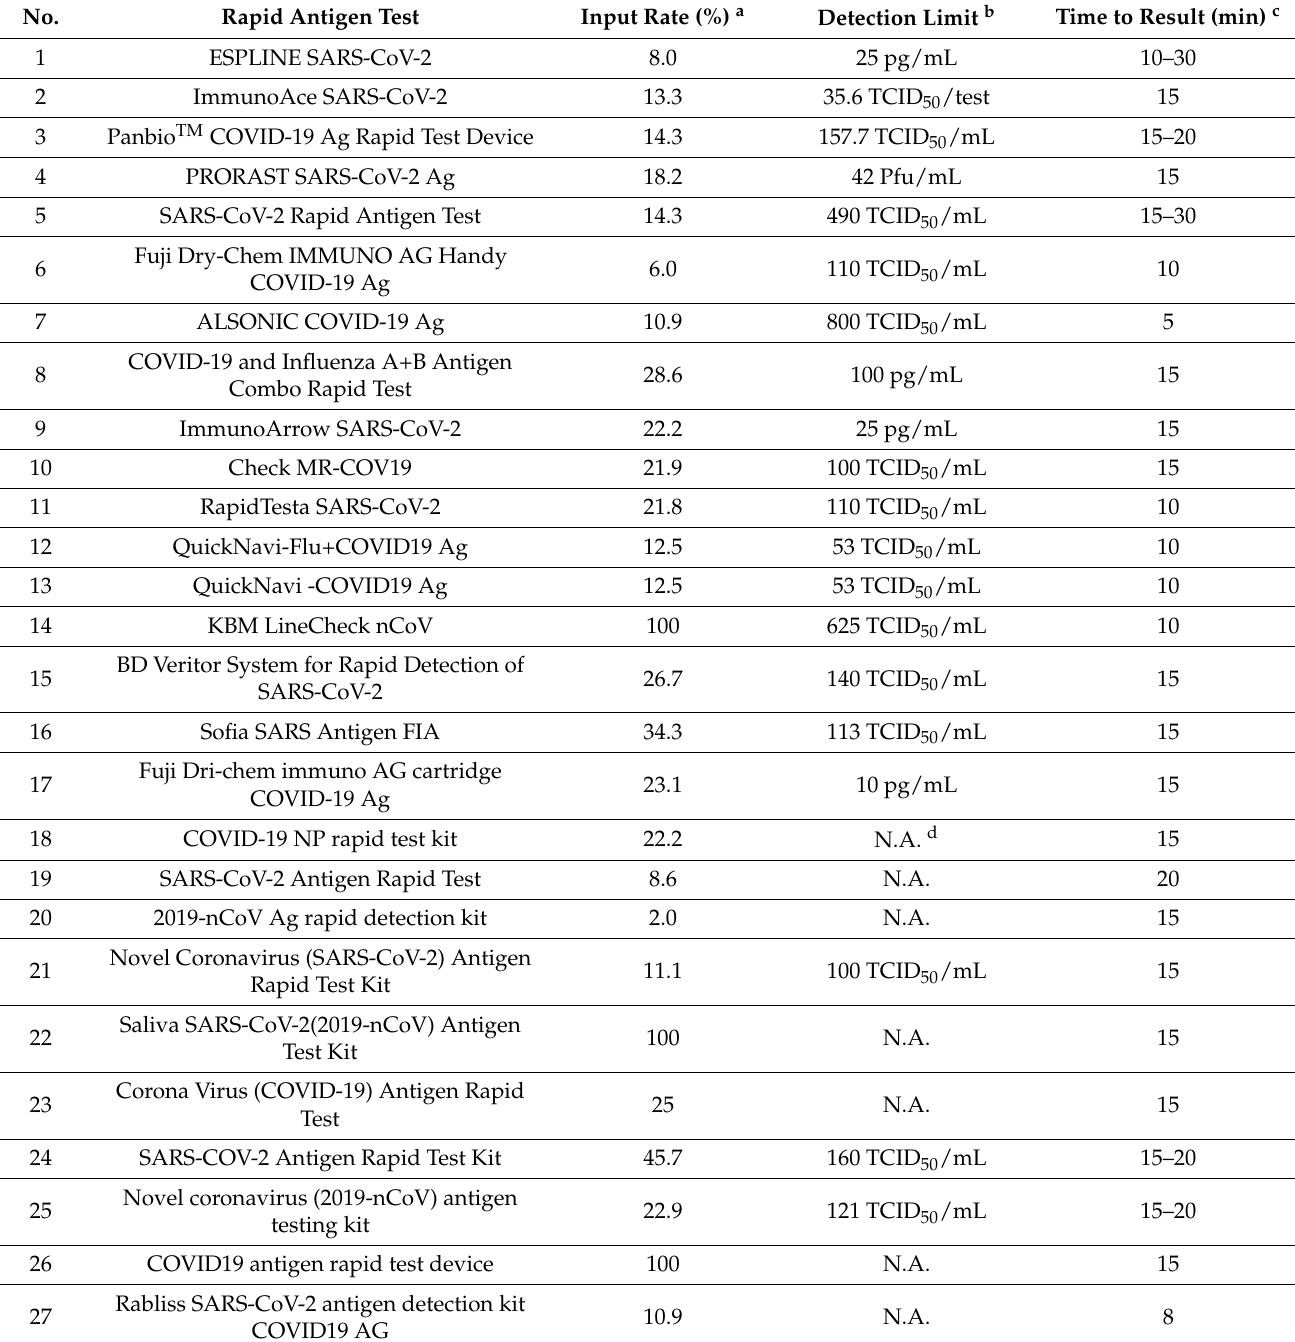
Table 2. Rapid antigen tests for